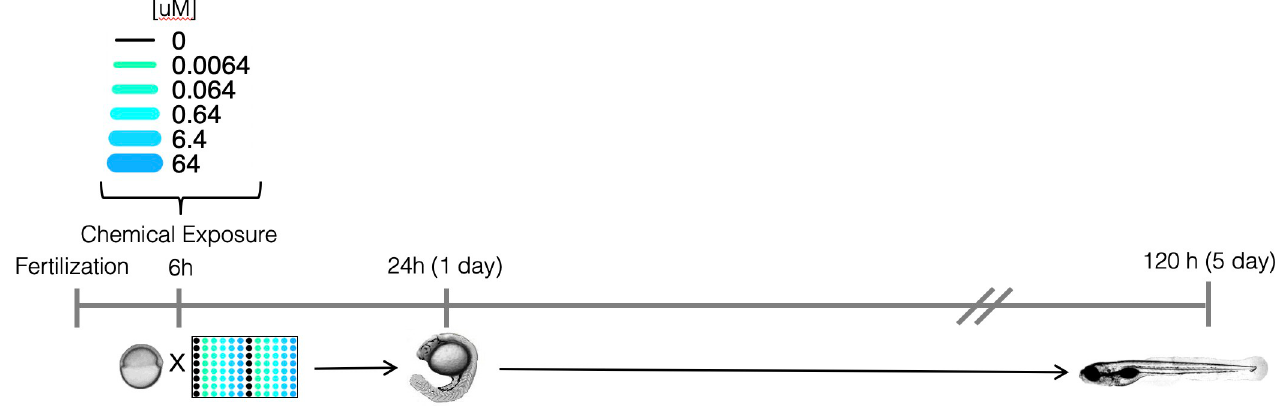
Fig 4. Experimental design. Schematic representation of the experimental approach for screening developmental and neurotoxicity of chemicals in larval zebrafish.